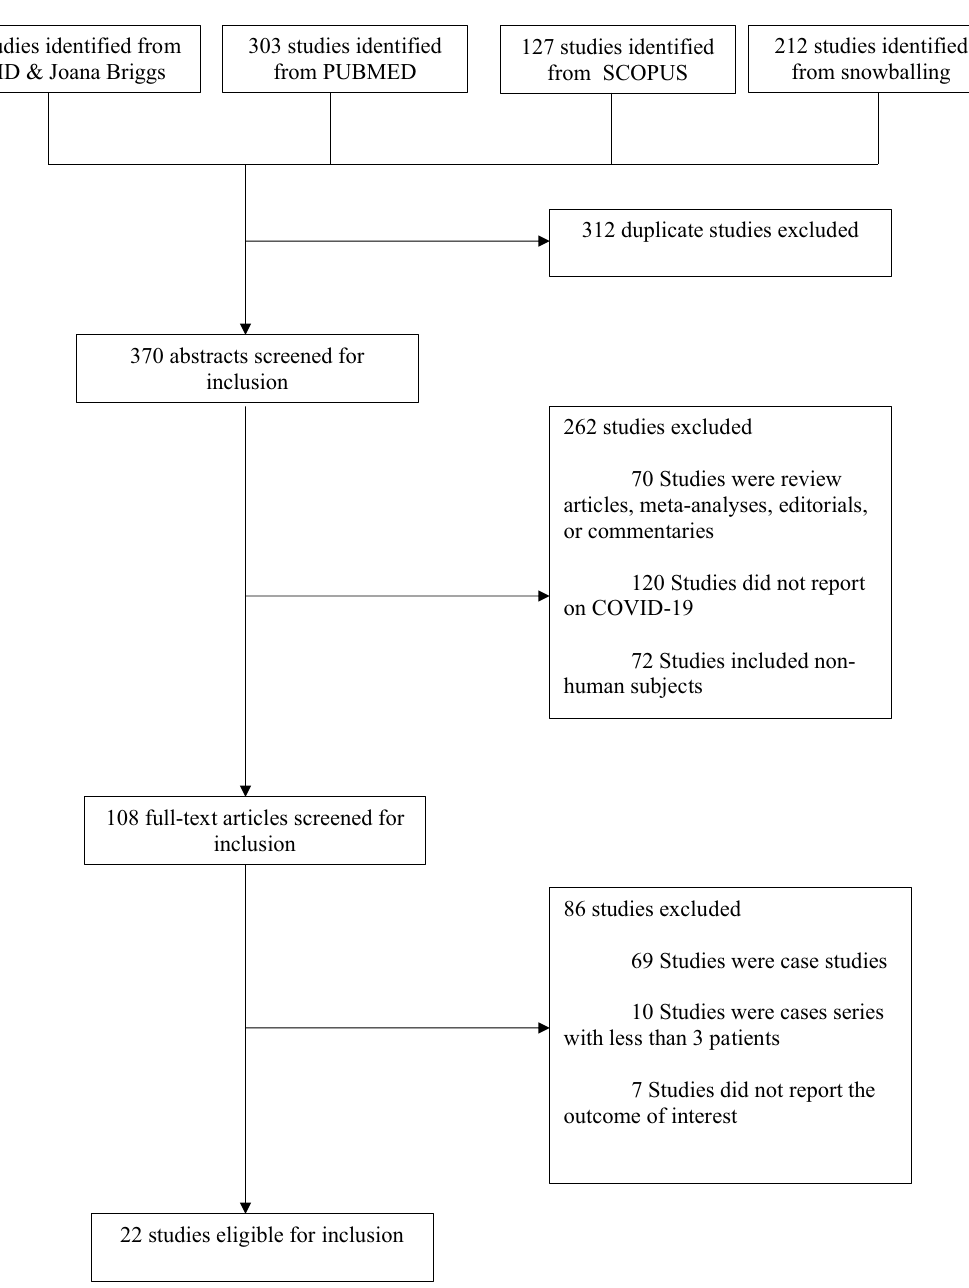
Figure 1. PRISMA flowchart of a systematic review and meta-analysis of HIV and SARS-CoV-2